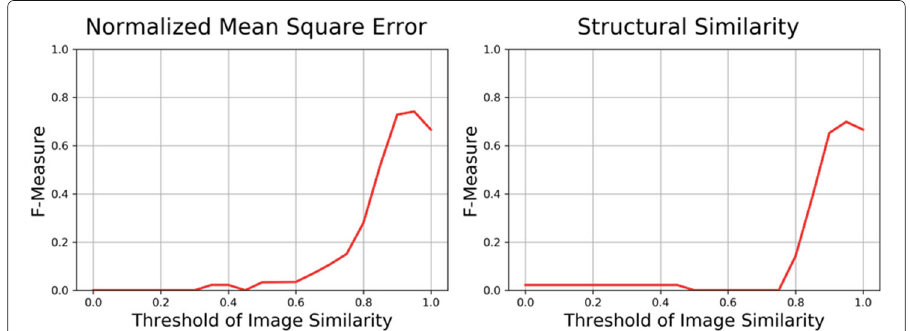
Fig. 5 Optimal threshold for NMSE and SSIM